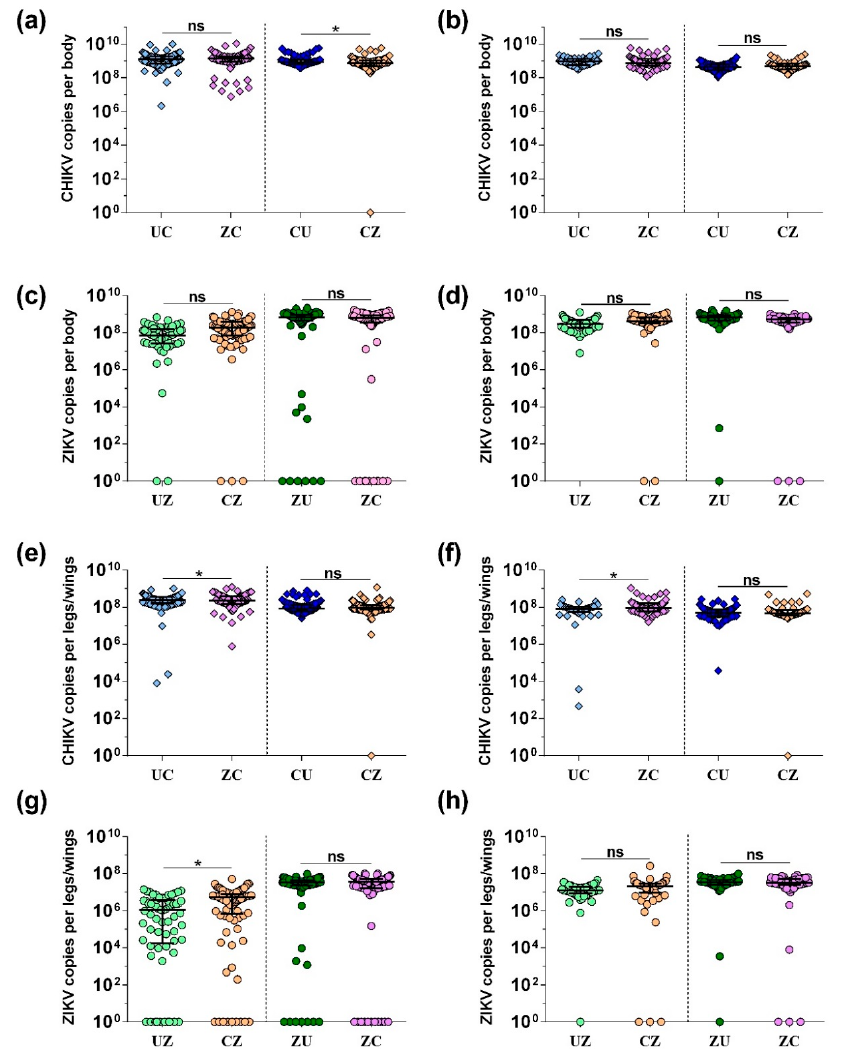
Figure 2. Viral RNA copy numbers in the bodies and legs/wings of single and dual infected Ae. aegypti mosquitoes . CHIKV copy numbers in mosquito bodies are shown for ( a ) 7 dpi and ( b ) 12 dpi. ZIKV copy numbers in mosquito bodies are shown for ( c ) 7 dpi and ( d ) 12 dpi. CHIKV copy numbers in mosquito legs and wings are shown for ( e ) 7 dpi and ( f ) 12 dpi. ZIKV copy numbers in mosquito legs and wings are shown for ( g ) 7 dpi and ( h ) 12 dpi. All viral copy numbers were quantified using qRT-PCR and are shown combined from three replicate experiments. The median, including zero values log10(x + 1) transformed, is indicated and error bars show the interquartile range. ANOVA was used to determine statistical significance as indicated (* p < 0.05), taking replicates into